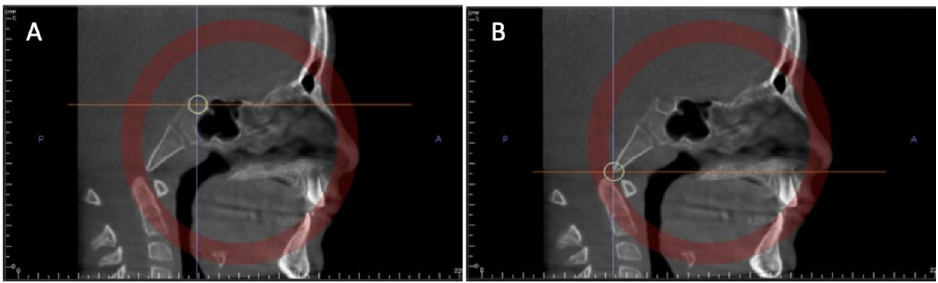
Figure 3. Spheno-occipital synchondrosis ossification assessment: Middle of sella turcica in the sagittal view ( A ). Anterior border of the foramen magnum in the sagittal view ( B ).